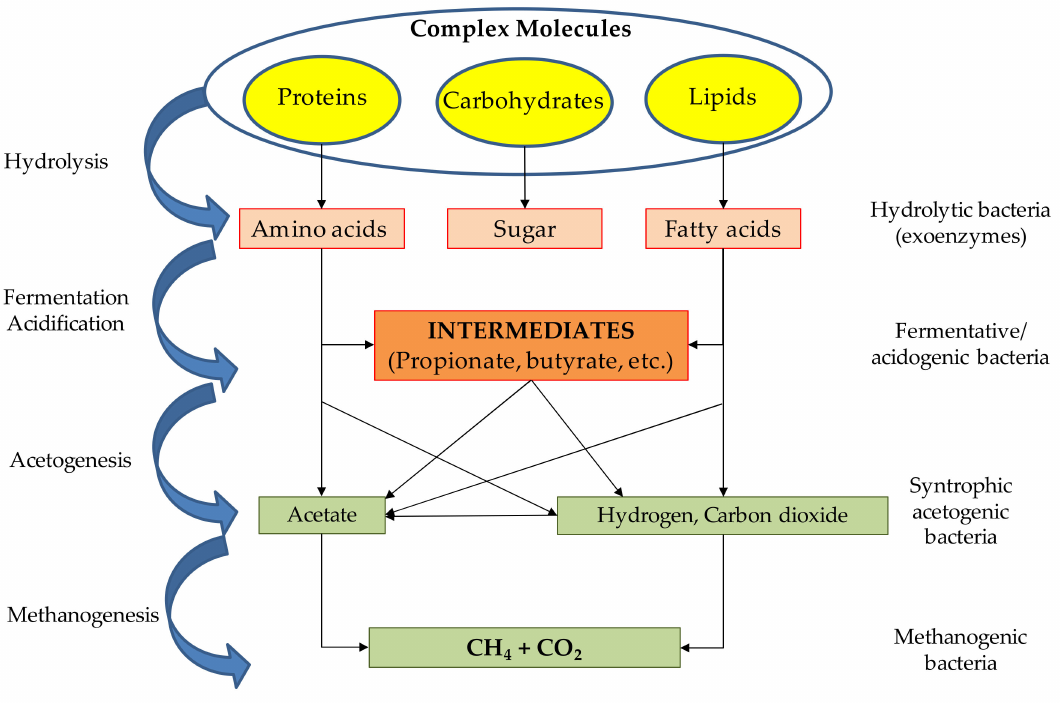
Figure 3. Phases of the anaerobic digestion process